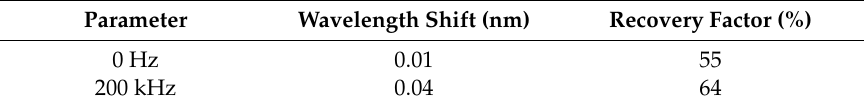
Table 2. Wavelength shift and recovery factor of injected Fe 3 O 4 nanomaterials.